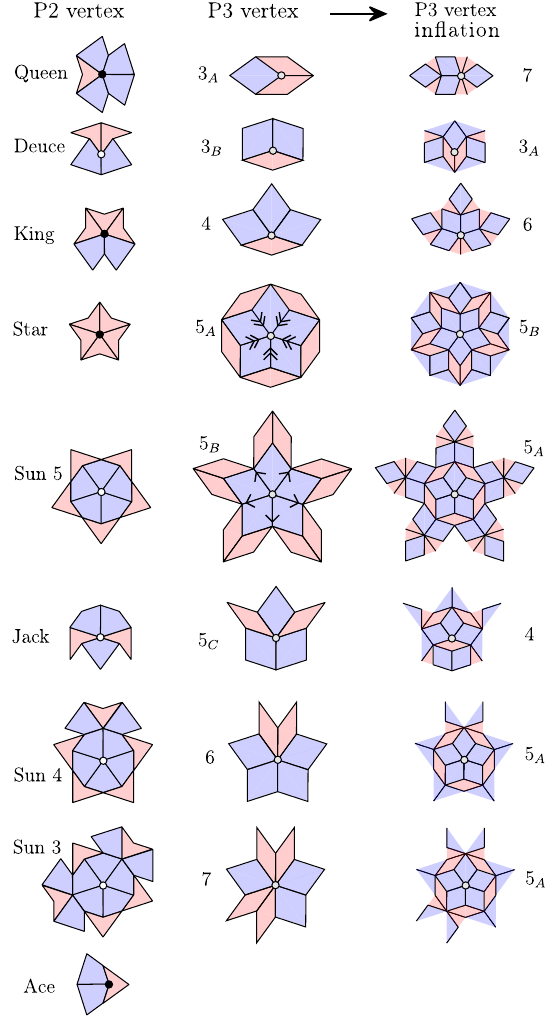
FIG. 2. (a) The Penrose tiling can be created by decorating the rhombuses with matching rules , where the decorations of neighboring edges must match. (b) An alternative method of creating the tiling uses inflation rules , in which each tile is subdivided into a combination of the two tiles as shown. Black lines indicate graph edges and gray circles graph vertices. (c) Decorating the tiles leads to different Penrose tilings made from different tile types: the P 1 pentagonal tiling and the P 2 dart- kite tiling.